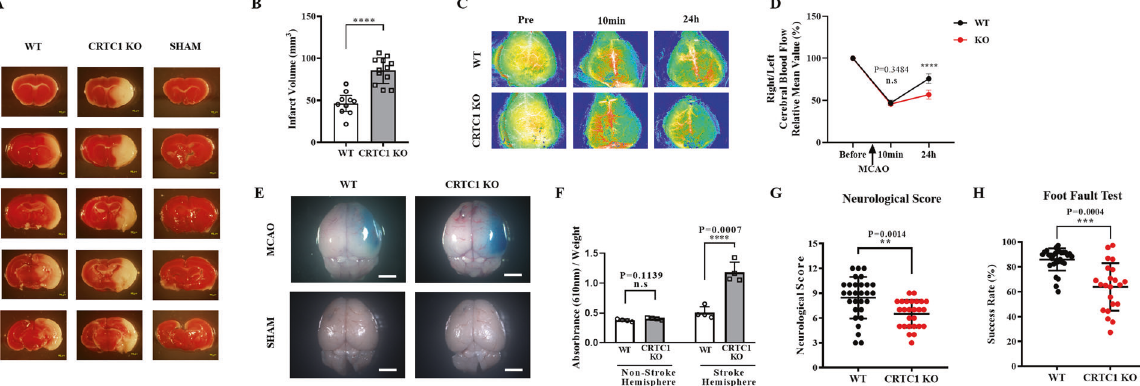
Fig. 2 CRTC1 de fi ciency exaggerates blood – brain barrier breakdown and mice forelimb recovery after ischemia. A Representative TTC staining images of CRTC1 KO and WT mice brain sections 24 h after MCAO. B Quanti fi cation of infarct volume of CRTC1 KO and WT mice. n = 10 for each group. C Cerebral blood fl ow (CBF) pictures of CRTC1 KO and WT mice before and after MCAO. D Quanti fi cation of relative CBF change of right/left MCA responsible area. n = 10 for each group. Representative images ( E ) and quanti fi cation ( F ) of Evans Blue extravasation in CRTC1 KO and WT mice brains after MCAO. n = 4 for each group. Mice behavior de fi cits 24 h after MCAO were examined by Neurological Score ( G ) and Foot fault Test ( H ). n = 29 for WT, n = 26 for CRTC1 KO.